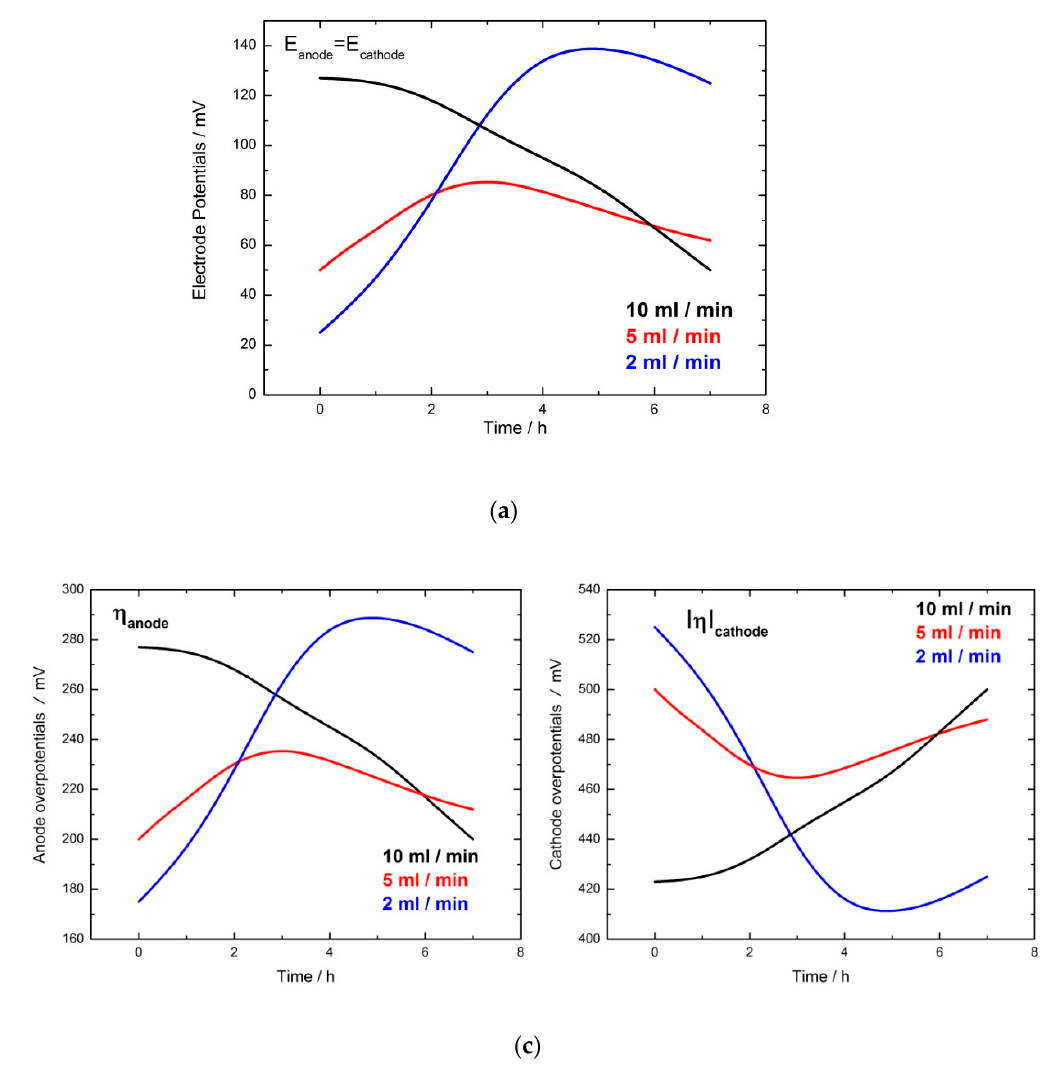
Figure 4. Change of ( a ) anode and cathode electrode potentials (Ea = Ec); ( b ) anode overpotential; ( c ) cathode overpotential during 7 h of reactors operation at Ucell = 0.0 V.